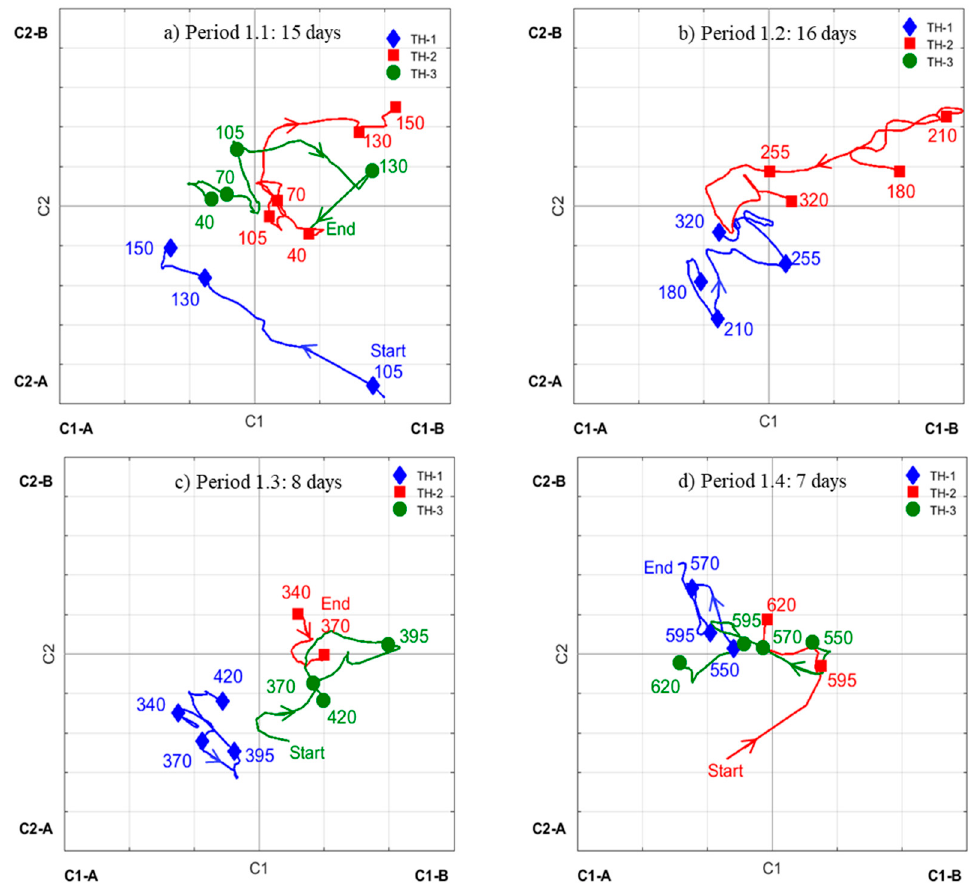
Figure 7. First vs. second principal components progression (C1, C2) corresponding to Data set 1 at di ff erent tap labels. ( a ) Period 1.1, ( b ) Period 1.2, ( c ) Period 1.3, ( d ) Period 1.4.